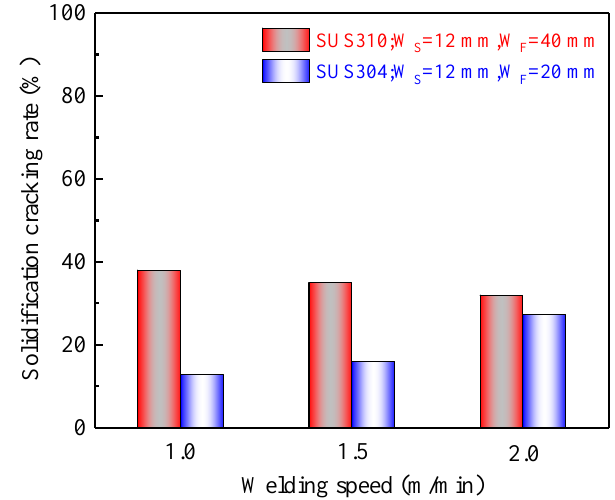
Figure 12. E ff ect of the welding speeds on the solidification cracking rate during laser Figure 12. Effect of the welding speeds on the solidification cracking rate during laser welding.